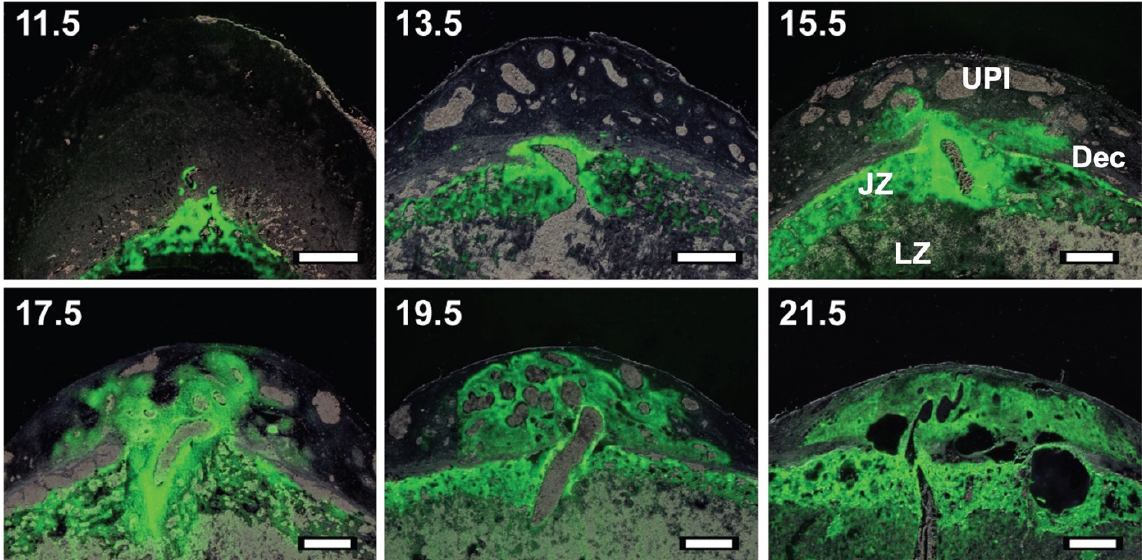
Figure 3. Infiltration of invasive trophoblast cells into the uterine-placental interface during the second half of gestation. Invasive trophoblast cells were identified in placentation sites of wild-type female rats mated with males possessing a chicken β -actin promoter-enhanced green fluorescence protein transgene. Green fluorescence reflects trophoblast cells within the placenta and invasive trophoblast cells which have migrated into the uterine-placental interface. Note the expansion of invasive trophoblast cells into the uterine-placental interface as gestation progresses. Abbreviations: UPI, uterine-placental interface; Dec, decidua; JZ, junctional zone; LZ, labyrinth zone. (Adapted from Reference